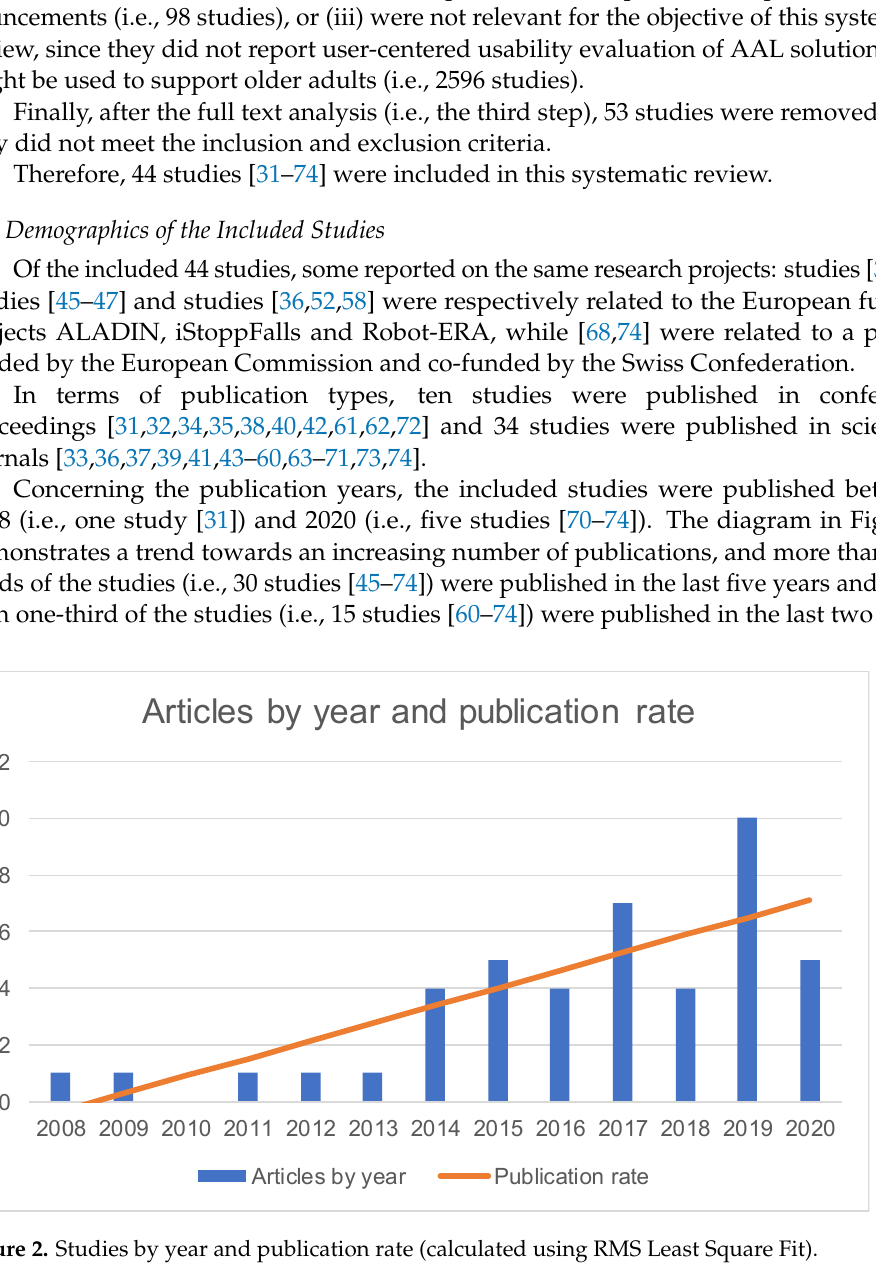
Figure 3. Distribution of the selected studies by country. Table 1. Multinational teams. References Multinational Teams [33]